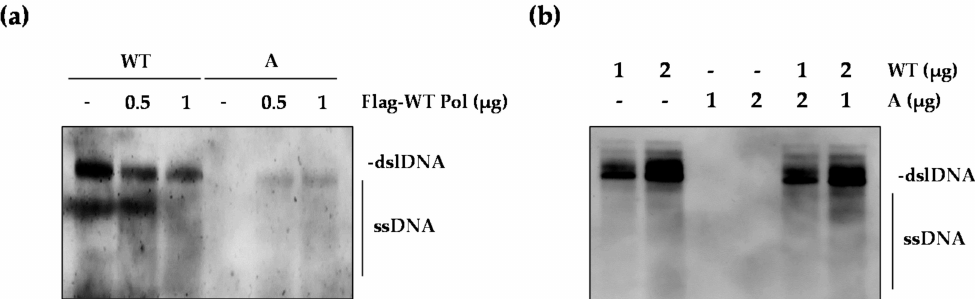
Figure 6. Impact of the HBV polymerase harboring rtT301A mutation on replication of WT HBV. ( a ) Effect of overexpressed WT Pol on the replication level of WT and rtT301A HBV mutant. Indicated plasmids were co-transfected into Huh7 cells. Total amount of plasmids was balanced with control vector. At three days post-transfection, cells were harvested for Southern blot. ( b ) Impact of rtT301A mutant on replication of WT HBV in Huh7 cells. Data in ( a , b ) were obtained from three independent experiments (mean ± SD).